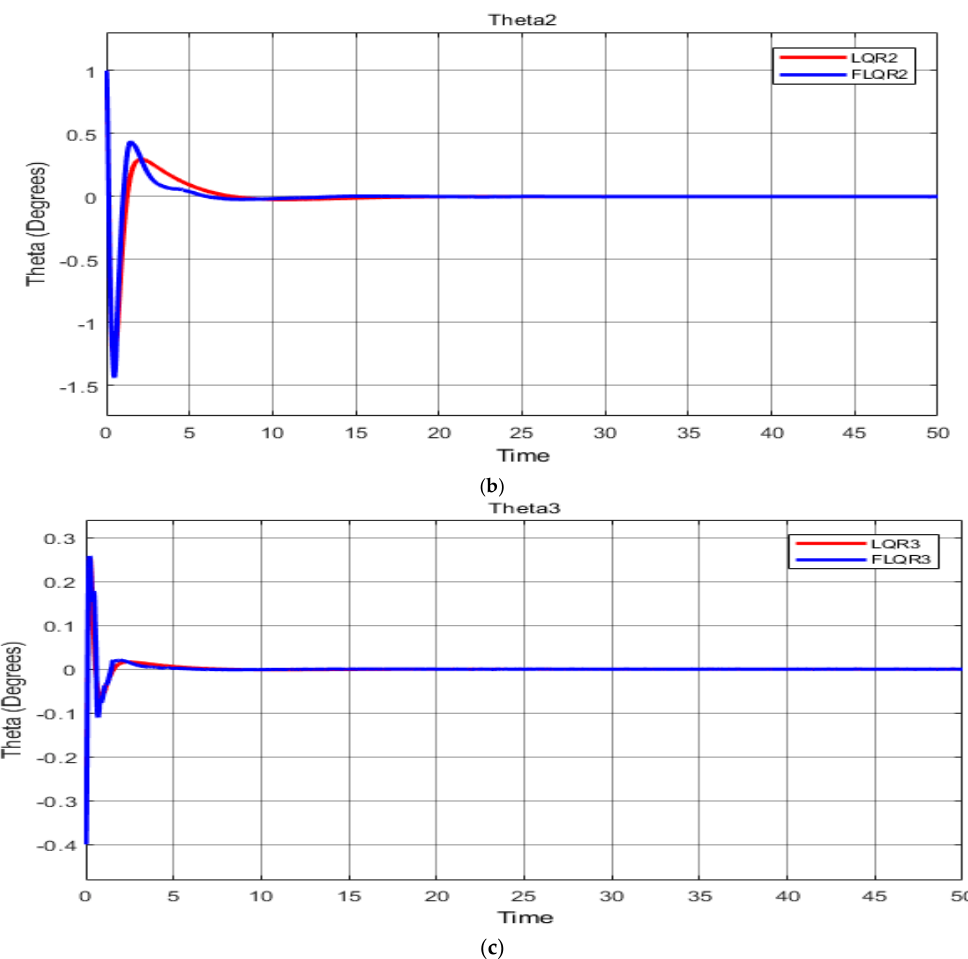
Figure 13. ( a ) The system response for 1st link of Robogymnast in Case 4 (T1); ( b ) The system response for central link of Robogymnast in Case 4 (T2); ( c ) The system response for link-3 of Robogymnast in Case 4 (T3).